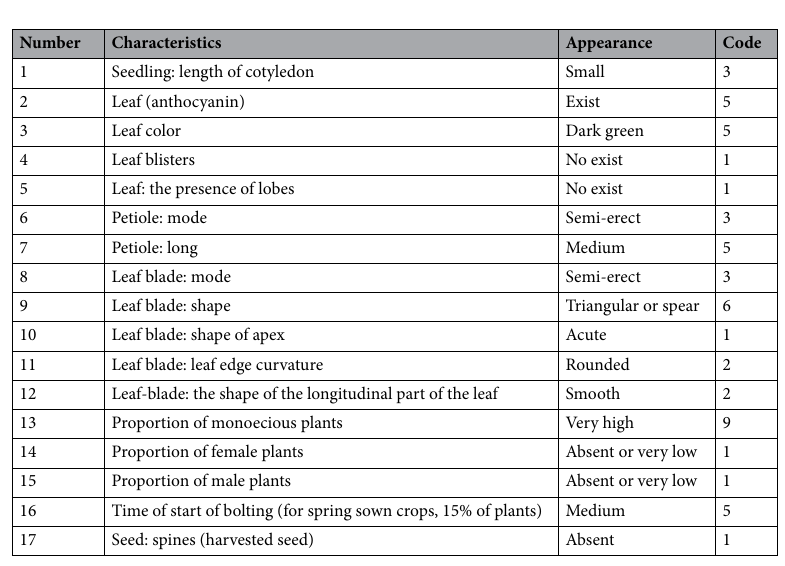
Table 2. Identification of medicinal spinach (MSP) according to the instructions of DUS testing spinach distinctness, uniformity, and stability-reference to UPOV 18 .